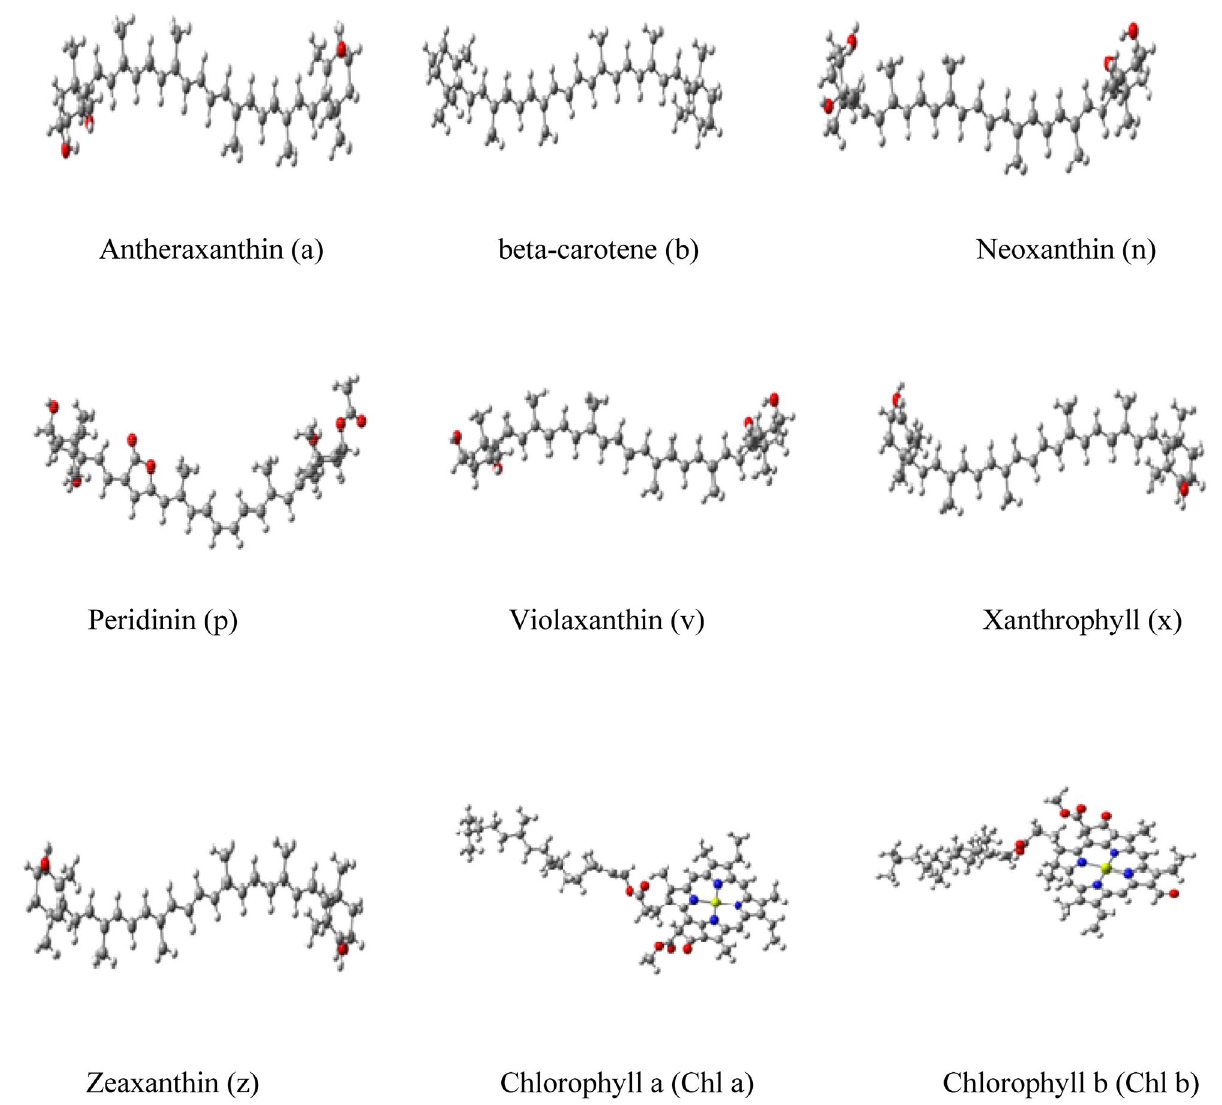
Figure 1. Optimized structures of carotenoids (wB97xD/6-31G**) and Chl a and Chl b (wB97xD/Lanl2dz:6- 31G**) method by DFT